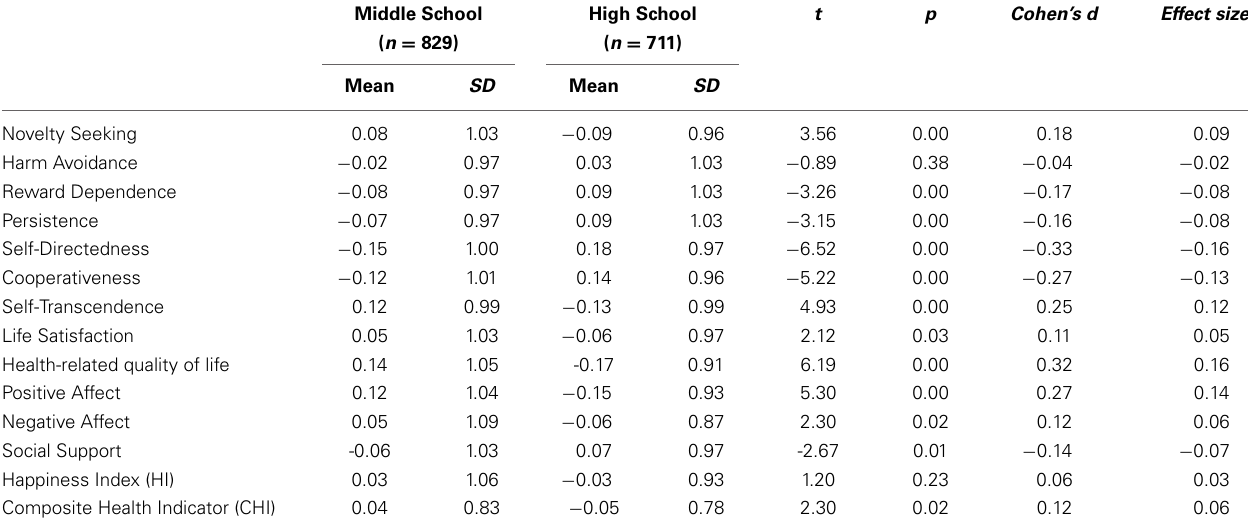
Table 2 | TCI dimensions (measured both with the JTCI and the TCI-R versions), measures of well-being, Happiness Index and Health Index by school level.